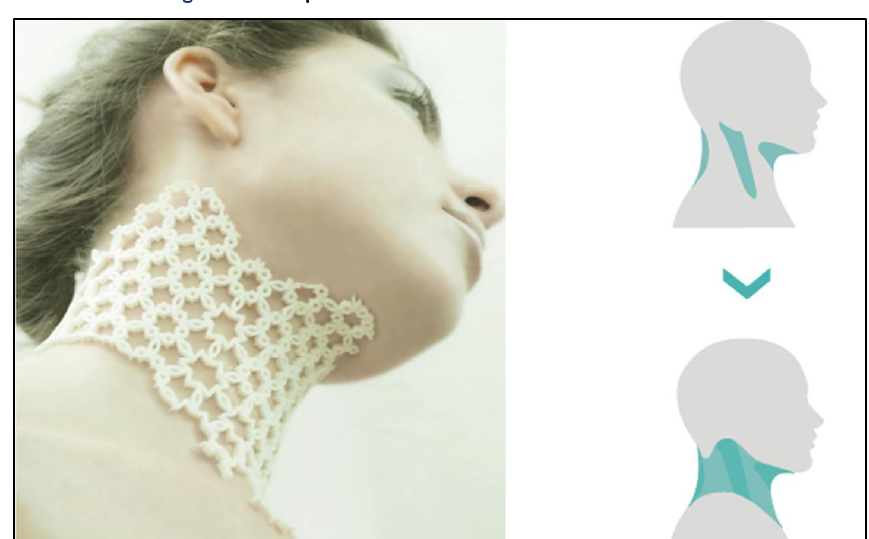
Figure 20. Optimisation of the support shape based on functional needs